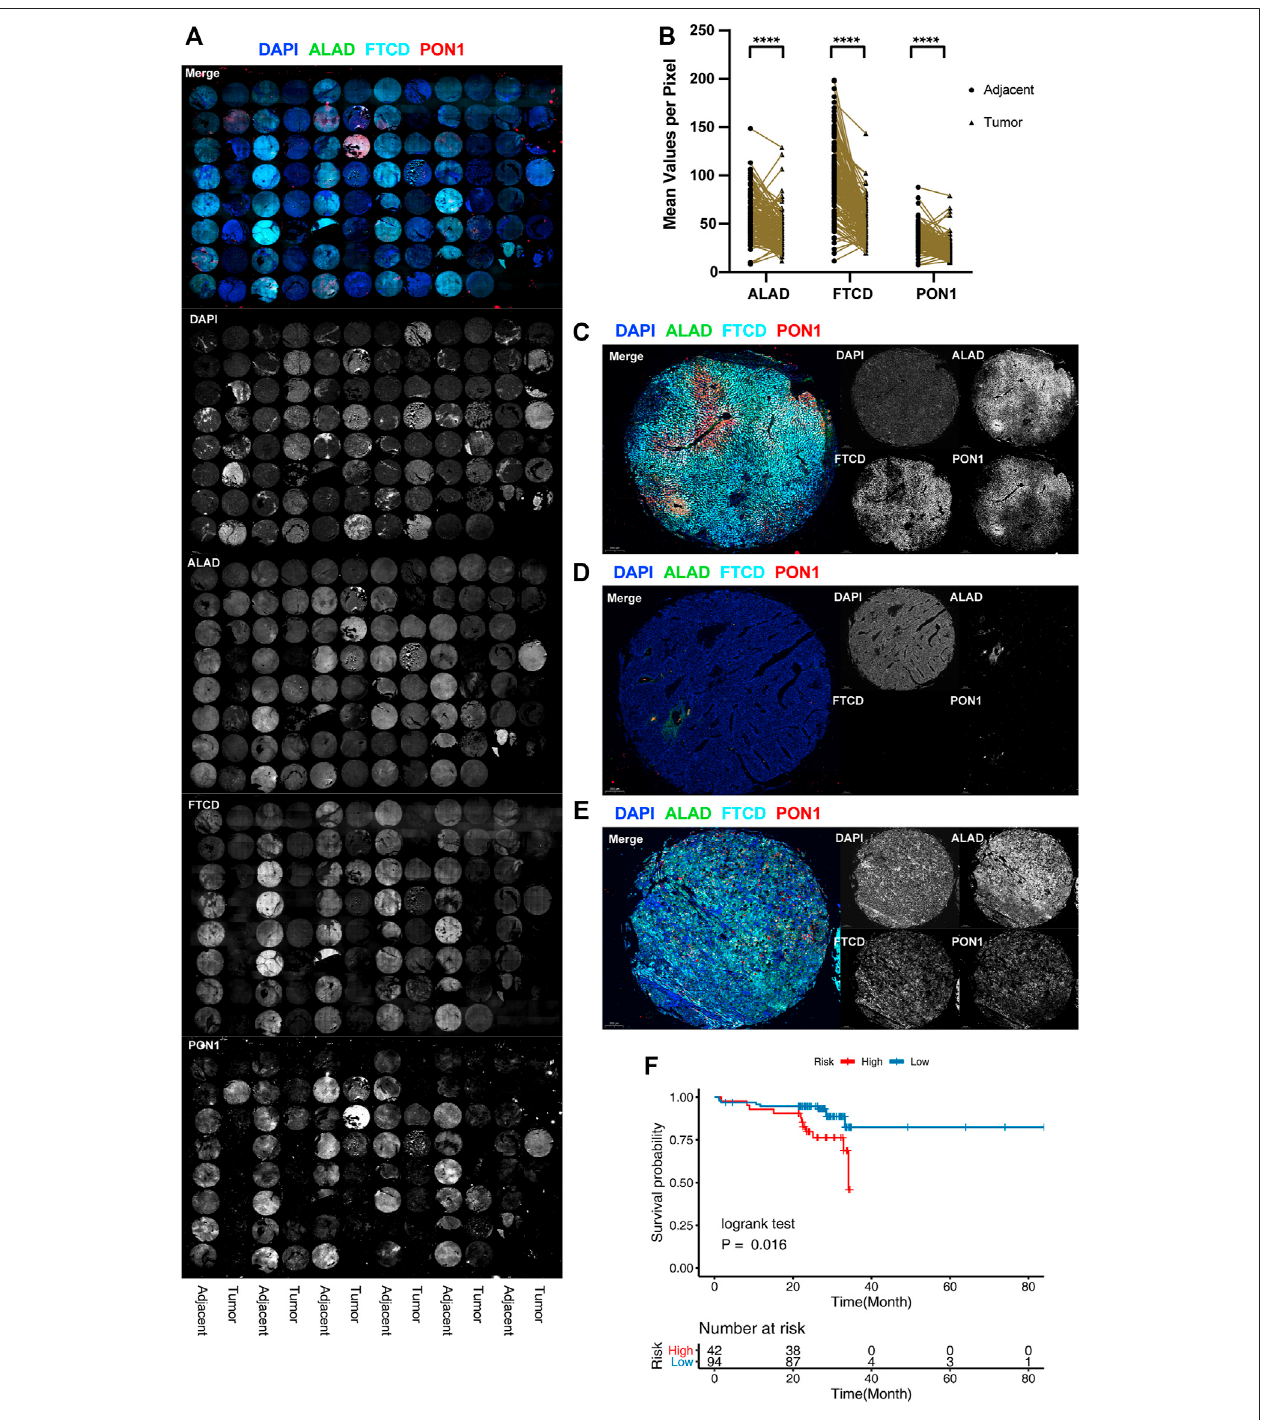
FIGURE 4 | Protein level validation for external cohorts. (A) Full tissue microarray scans with nuclei labeled with DAPI (blue), ALAD labeled with Alexa Fluor 488, FTCD labeled withAlexaFluor550,andPON1 labeled withCy5.Forbettervisualization,FTCDsignalsareconverted topseudo-color. (B) Distribution ofthedifferencein stainingintensitiesofALAD,FTCD,andPON1inHCCtissuescomparedwiththatinpairedadjacenttissues.(**** p < 0.001). (C – E) RepresentativeimagesofmulticolorIF staining in tissues. Adjacent tissues (C) , triple-negative tumor tissues (D) , and triple-positive tumor tissues with chaotic distribution (E) . (F) K-M plot of the three- gene prognosis model in 136 patient external validation cohorts.